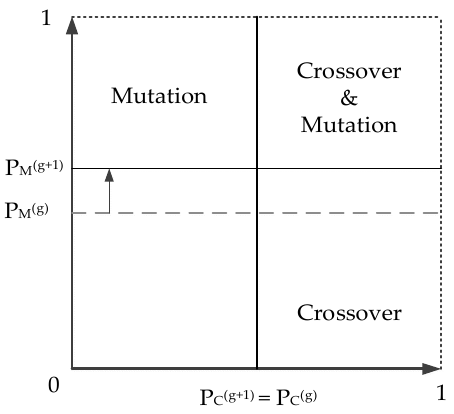
Figure 8. Variation for decreasing mutation probability.